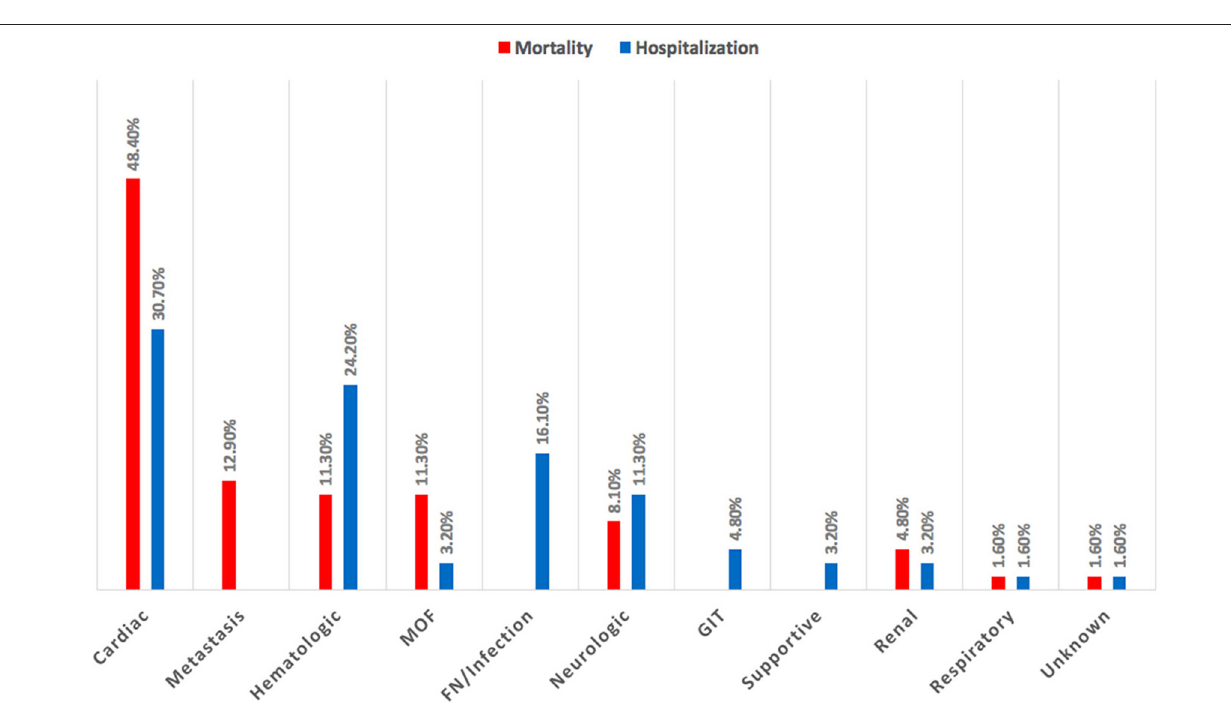
therapy the incidence of de novo or worsening HTN ranging between 17 and 80% (6–9). It is known that CVD and